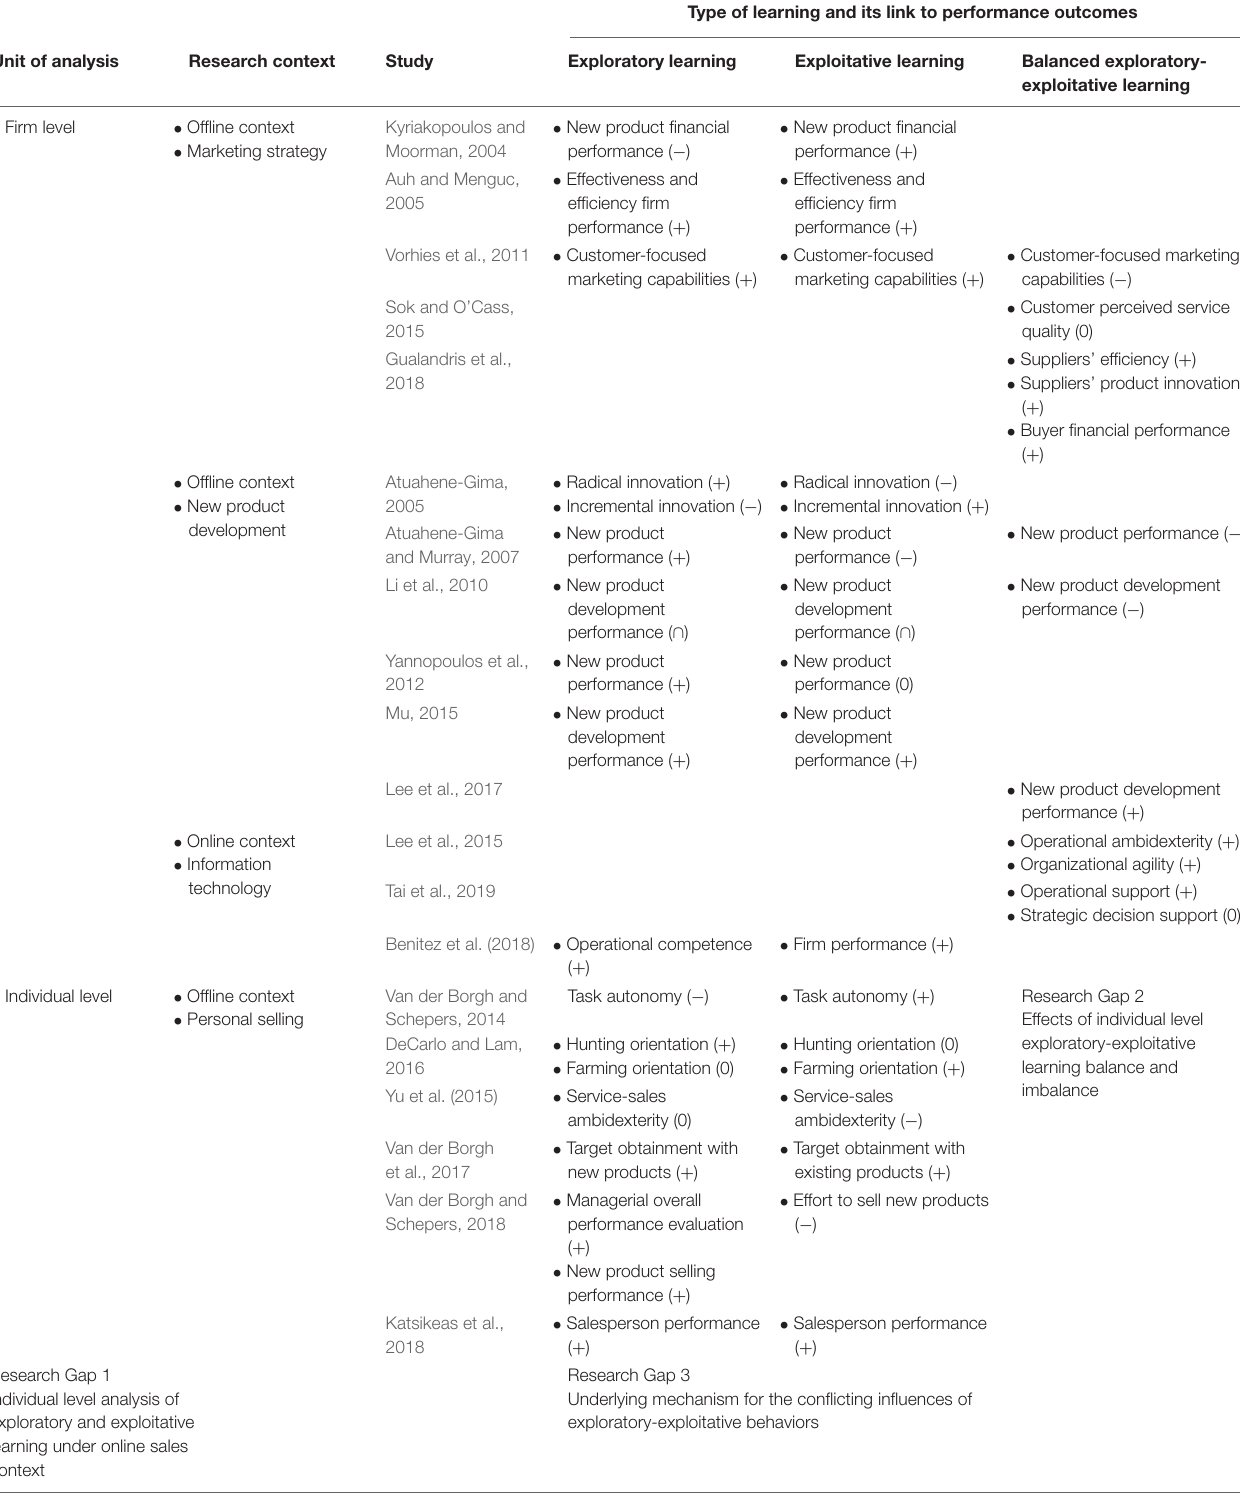
TABLE 1 | Selected studies on exploratory and exploitative